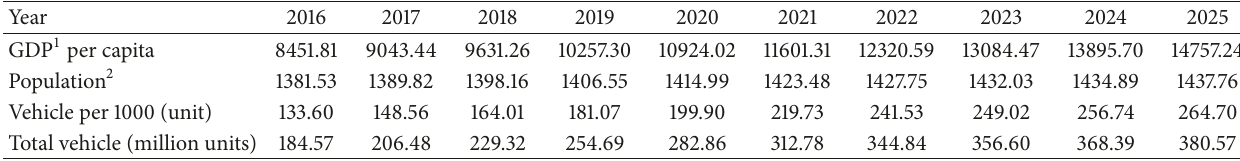
Table 5: Prediction of vehicle ownership per 1000 people and total ownership to 2025 in China.